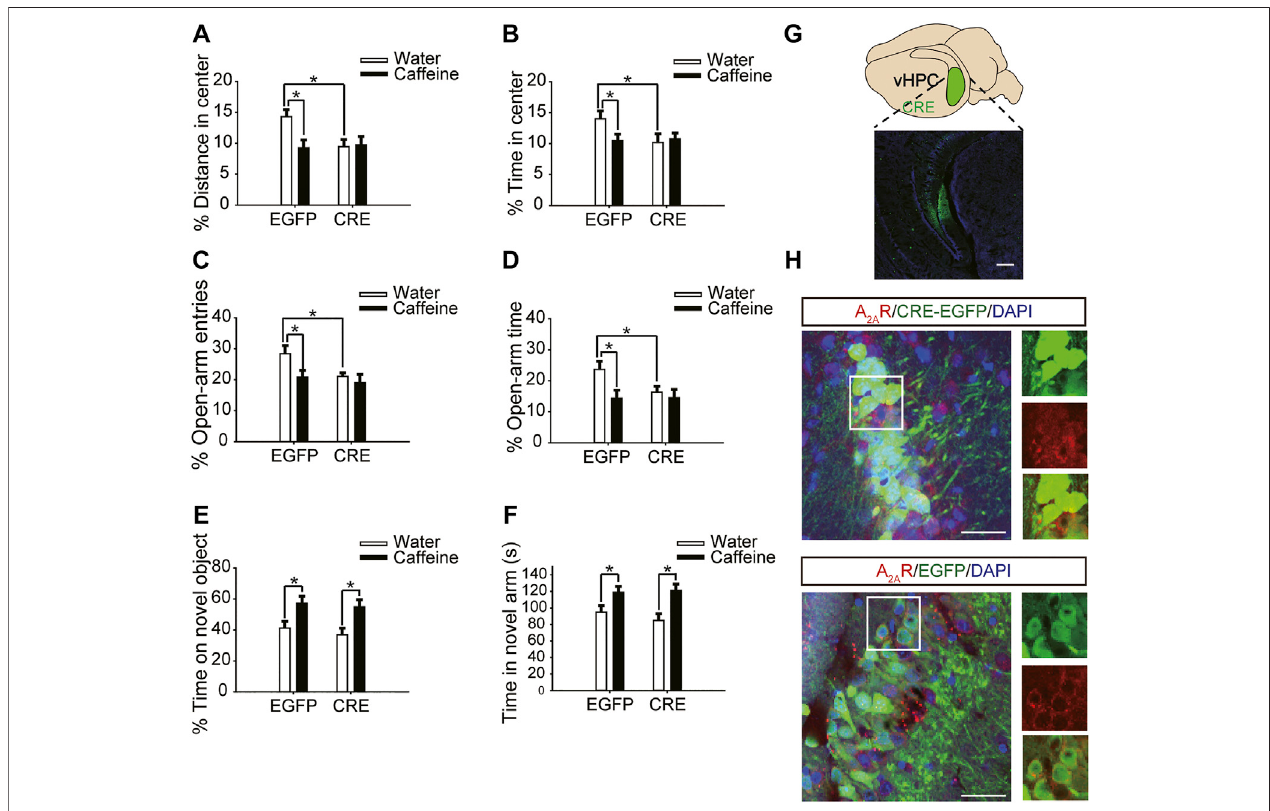
FIGURE 4 | Selective deletion of vHPC A 2A Rs triggers anxiety-like behaviors. (A,B) Behavior of the four groups of mice in the open- fi eld test. Caffeine induced anxiogenicbehaviorwithdecreasedtimeinthecenter (B) anddistanceinthecenter (A) onlyinEGFPmice. (C,D) BehaviorofthefourgroupsofmiceintheElevatedPlus Maze (EPM) test. Caffeine decreased the percentage of open-arm entries (C) and the percentage of time spent in the open arms (D) only in EGFP mice. (E) Behavior of thefourgroupsofmiceintheNovelObjectRecognition(NOR)test.ThetimespentexploringanovelobjectwasincreasedbycaffeineinEGFPandCREmiceduring the testing trial. (F) Behavior of the four groups of mice in the Y-maze test. The time spent in the novel arm was increased by caffeine in EGFP and CRE mice during the retrievalphase. (G) ExpressionofAAV-CREorAAV-EGFPinthevHPC(scalebar=500 μ m).Dataarepresentedasthemean±SEM; n =7micepergroup;* p < .05,two- way ANOVA, Bonferroni post hoc